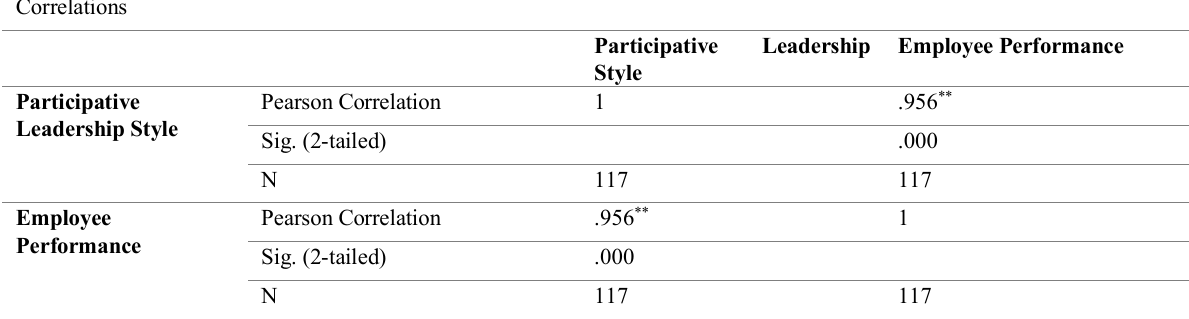
Table 8: Correlations between participative leadership style and employee performance